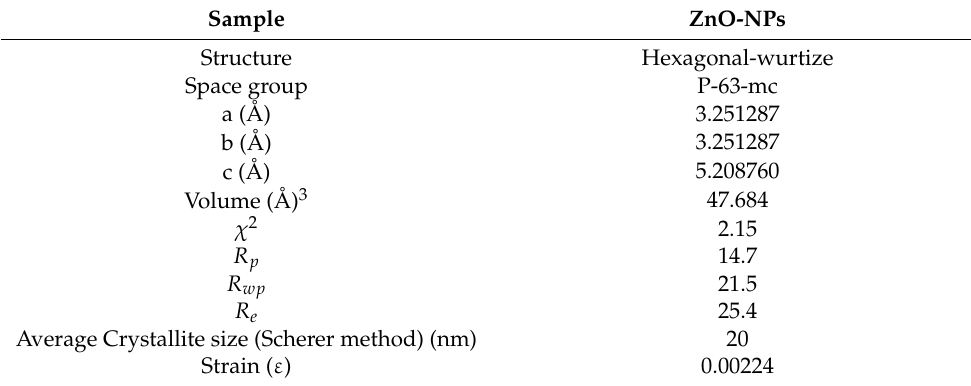
Table 1. Structural and Rietveld refine parameters of ZnO-NPs.